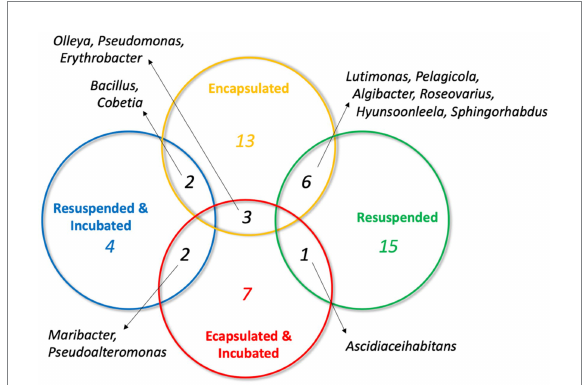
FIGURE 5 Venn diagram illustrating the distribution of shared OTUs between the four sediment treatments. Genera represented by the OTUs are